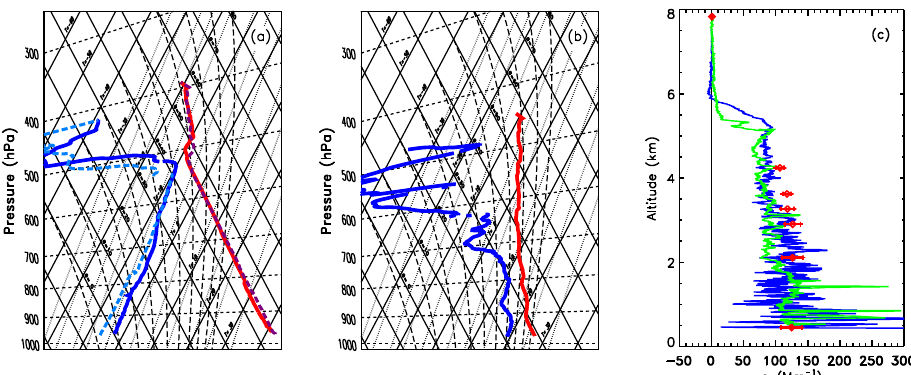
Fig. 2. (a) Tephigram derived during flight B705, from dropsondes launched at 13:13 (solid lines) and 13:20 (dashed lines): temperature (red and purple lines); dew point (dark and light blue lines). (b) Tephigram derived during flight B741 from a dropsonde launched at 15:08 (lines coloured as in a ). (c) Aerosol extinction coefficient profile for flight B705: derived by lidar using the slope-Fernald approach, when flying above the aerosol layer at 13:17 (355nm, blue line); derived by nephelometer and PSAP, during aircraft descent from 13:20 to 13:50 (550nm, green line); derived by nephelometer and PSAP, during straight level runs from 13:53 to 15:13 (550nm, red error bars).